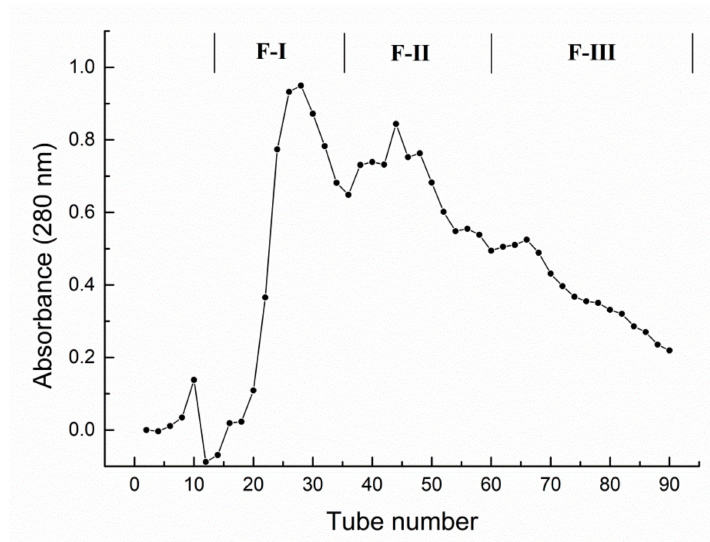
Figure 1. Separation of polyphenols from lotus seed epicarp by Sephadex LH-20 gel column into Fraction-I (F-I), Fraction-II (F-II), and Fraction-III